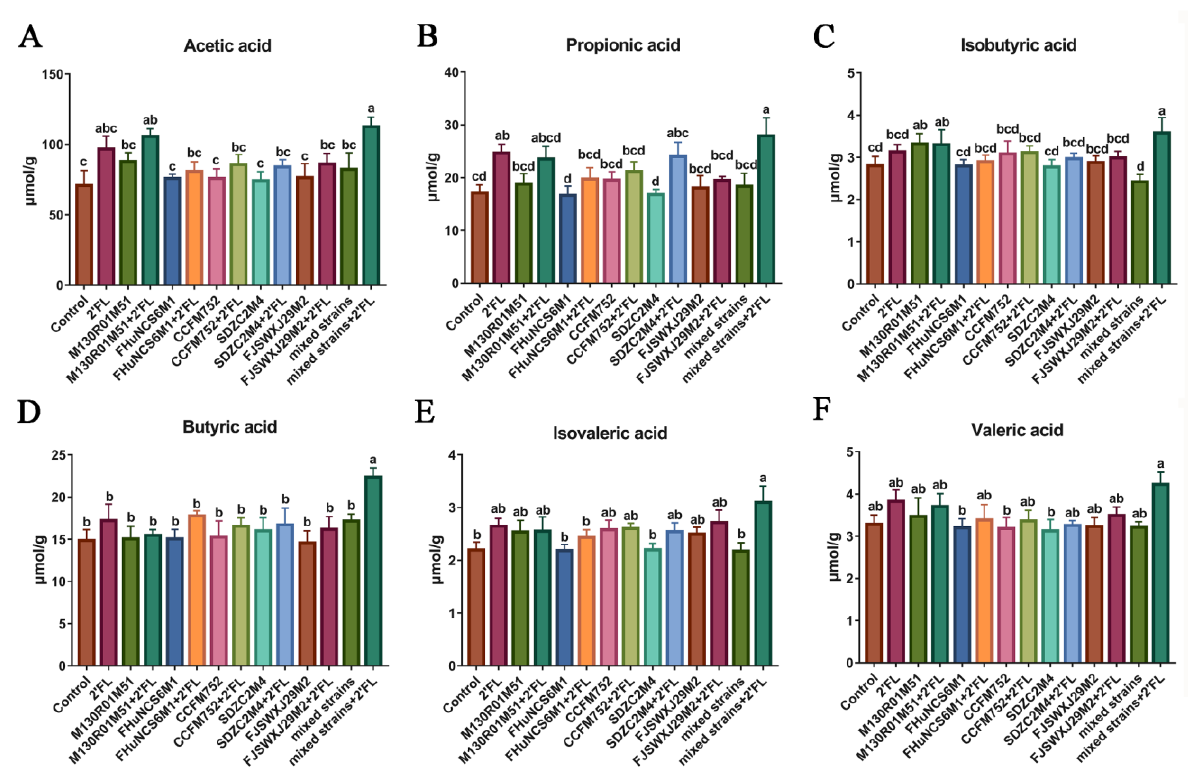
Figure 4. Effects of Bifidobacterium with different utilization of 2 ′ FL on the concentration of short- chain fatty acid content in feces (n=8). ( A ) Acetic acid, ( B ) propionic acid, ( C ) isobutyric acid, ( D ) butyric acid, ( E ) isovaleric acid, and ( F ) valeric acid. Statistical differences were calculated by ANOVA followed by Duncan analysis and different letters indicate significant differences between the groups ( p <